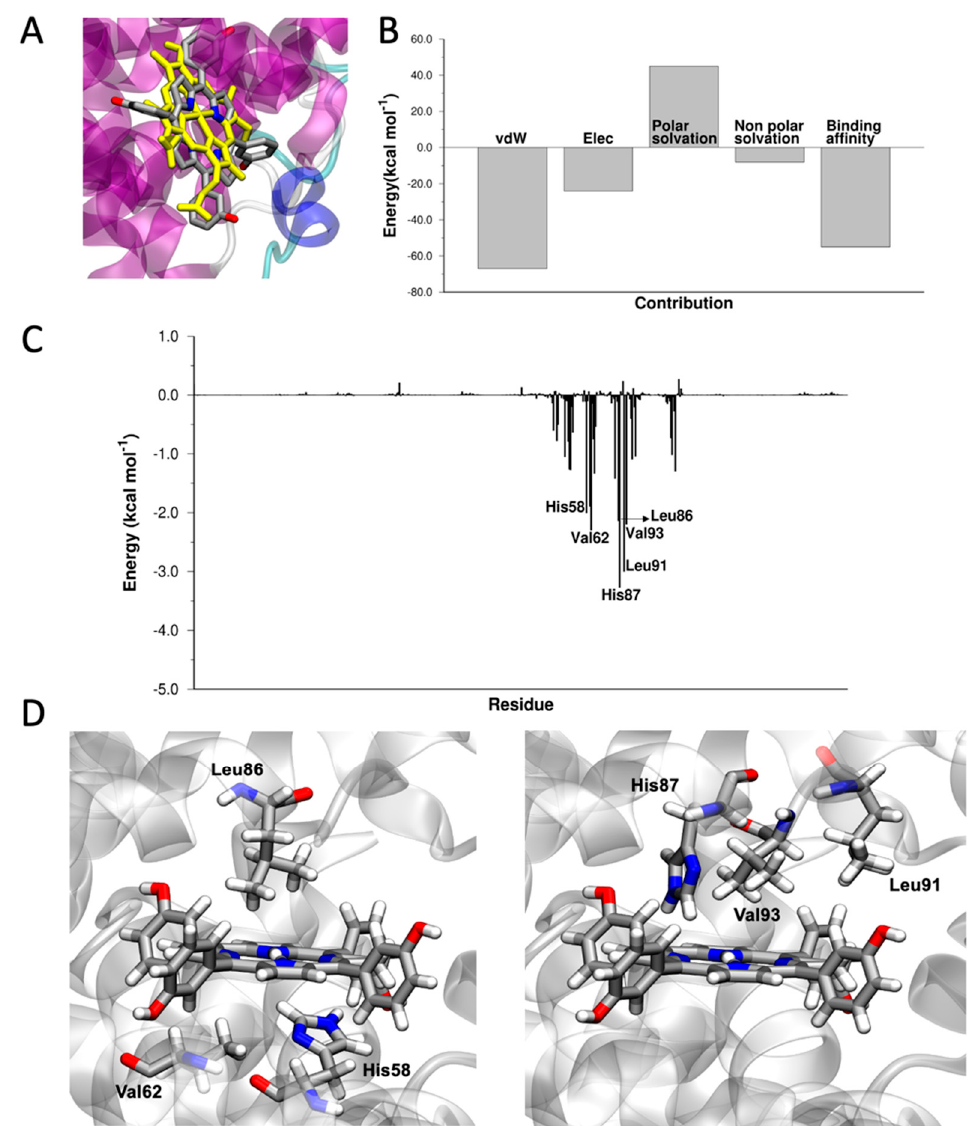
Figure 2. ( A ) Superposition of the crystallographic structure of heme (in yellow, PDB 2m6z) and docked structure of mTHPC in the heme-binding site of Hb. ( B ) Energy components of ∆ E binding . ( C ) ∆ E binding decomposed per residue. ( D ) Graphical representation of the interaction between His58, Val62, Leu86, His87, Leu91, Val93, and mTHPC. Images created with VMD [73].